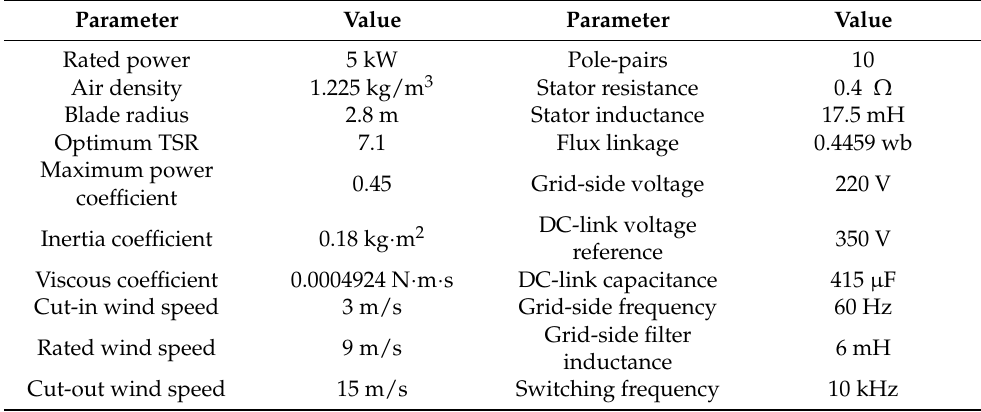
Table 1. Main parameters of the PMVG-based wind energy system